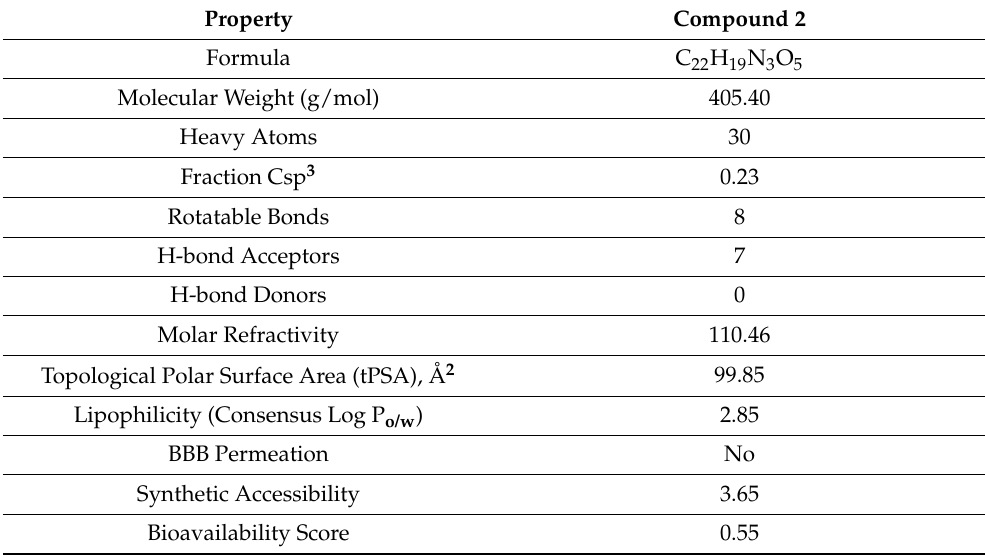
Table 1. Physicochemical ADME properties of Compound 2